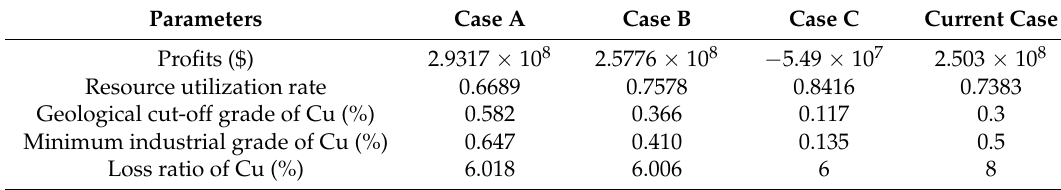
Figure 12. Pareto-optimal solutions for the mine production process optimization using NSGA-II. Table 4. Optimization results of four typical cases of production indicators.